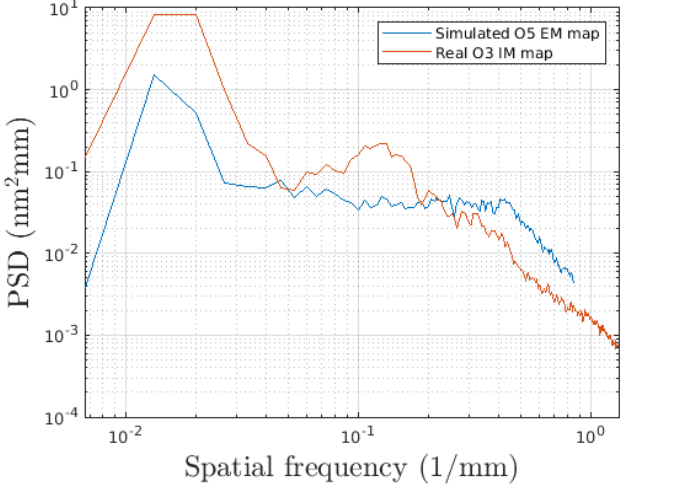
Figure 4. PSDs of the used surface maps. The PSD of the IM’s map has a bump at a spatial frequency of 0.1/mm. This can lead to scattering reaching the baffles in the walls of the tube.